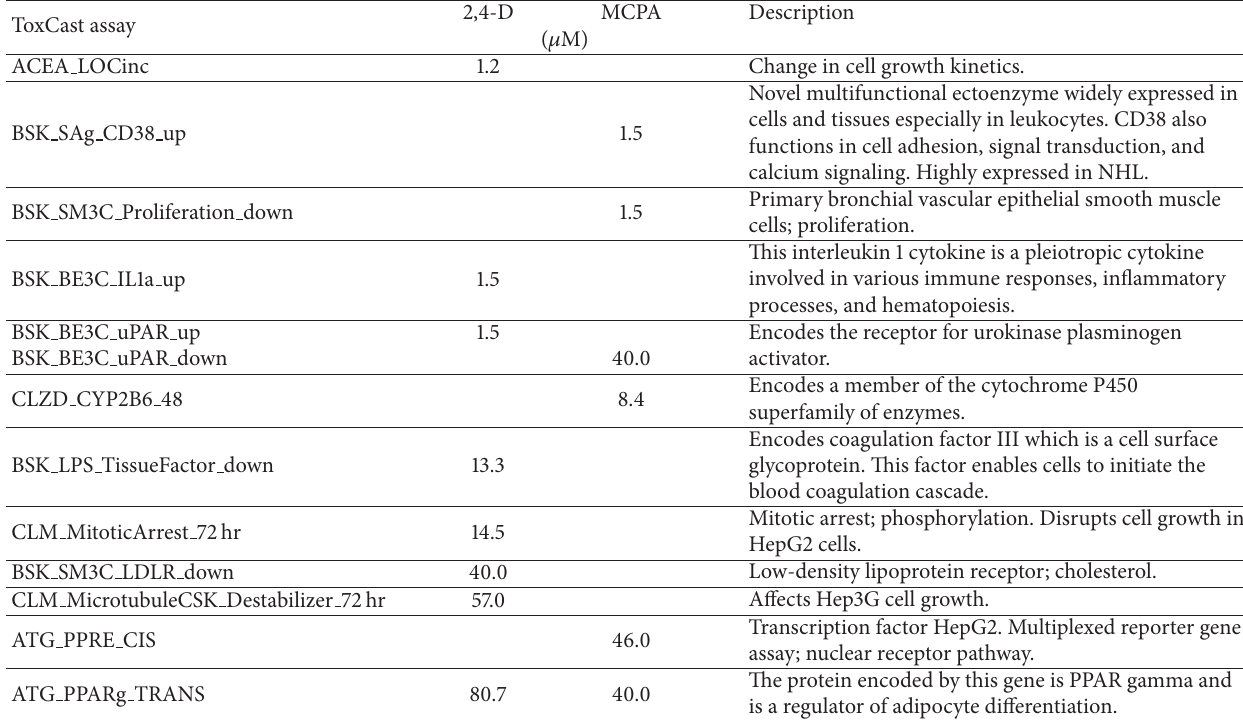
Table 5: ToxCast assay results for 2,4-D and